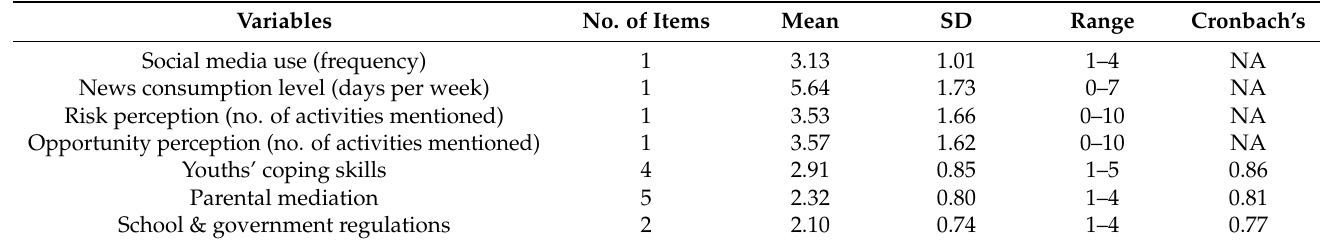
Table 3. Descriptive statistics and internal consistency of key variables in the opinion